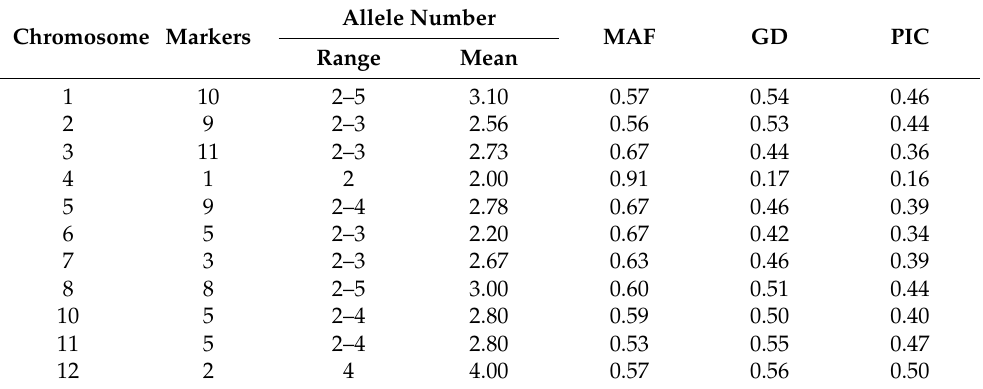
Table 4. Chromosome-wise summary of genetic variation based on 71 microsatellite